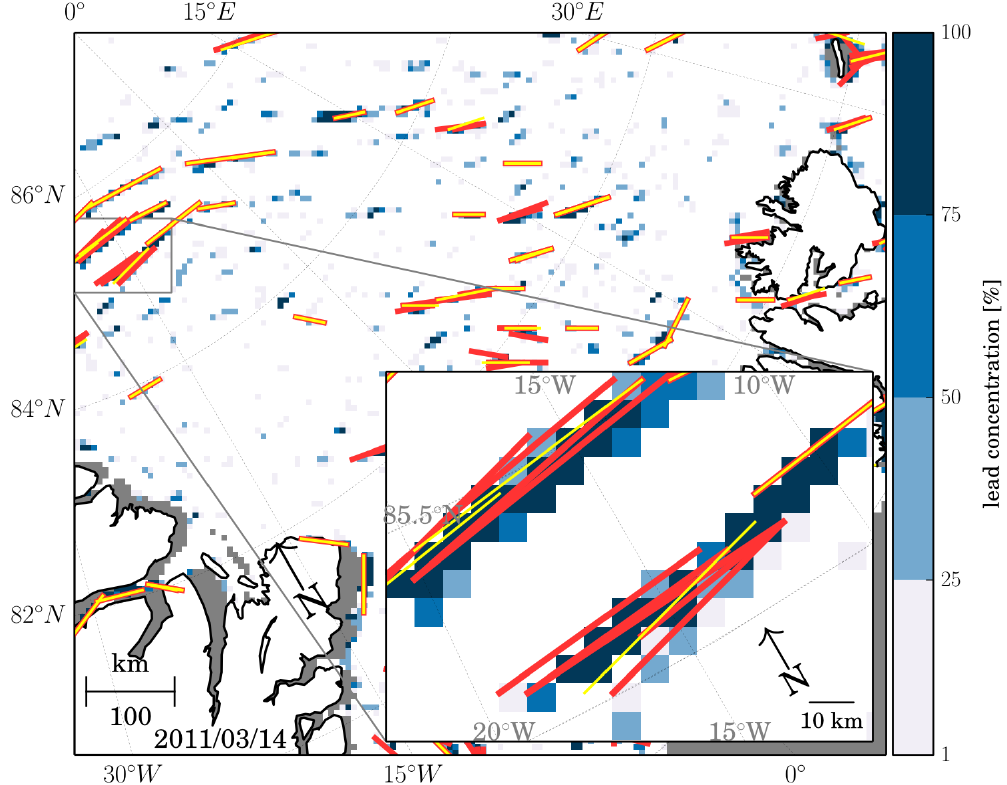
Figure 2. Comparison between unclustered leads (red lines) and clustered leads (yellow lines) in the Fram Strait and a regional zoom north of Greenland on 14 March 2011. The lead concentration is depicted in blueish colors. The cluster distance d equals 4 pixels or 25 km.